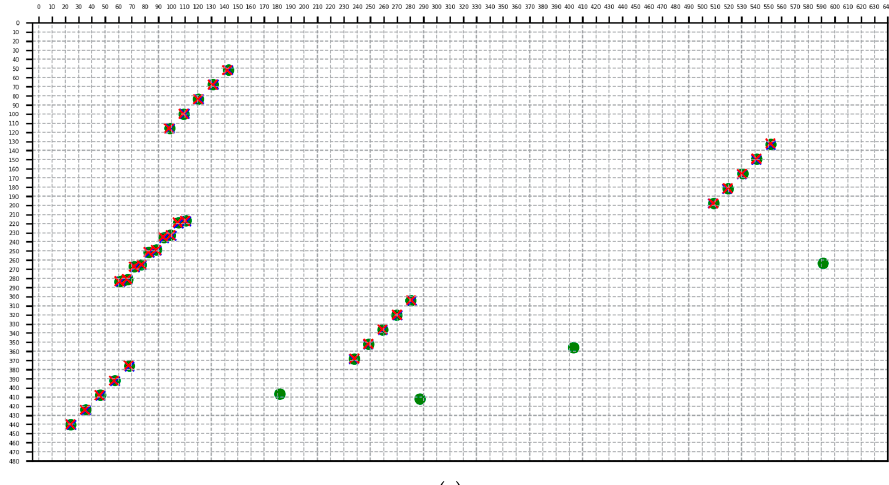
Figure 9. Performance of the proposed multi-frame space object detection method on the test set: ( a )-( c ) show the space targets that can be detected correctly in different spatial distribution within one sequence. The prediction results of PP-YOLOv2 detector are marked by the green solid circle; the final results after the post-process procedure of CFS are marked by the red cross symbols. Ad- ditionally, the blue cross symbols indicate the ground truth.